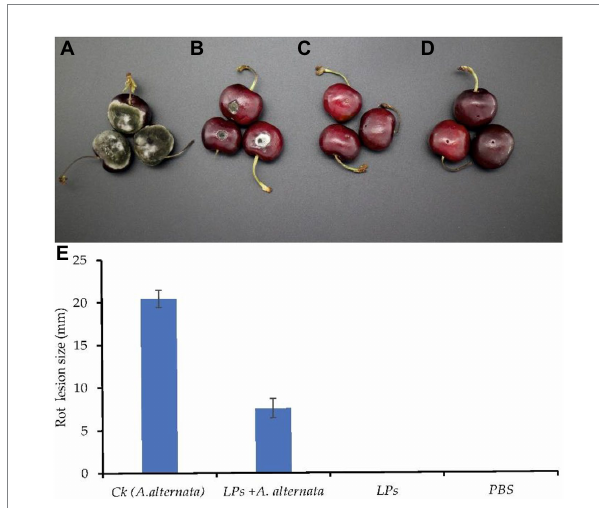
FIGURE 10 LPs from Y17B suppressed fruit rot development in cherry fruit. (A) Ck: cherry fruit infected with A. alternata only. (B) Treatment: cherry fruit infected with A. alternata and treated with LPs. (C) Cherry fruit treated with LPs only. (D) Cherry fruit treated with PBS only. (E) Mean values of rot lesion diameter ±